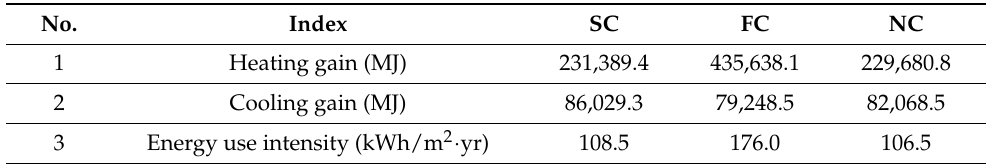
Table 3. Comparison of energy use by three